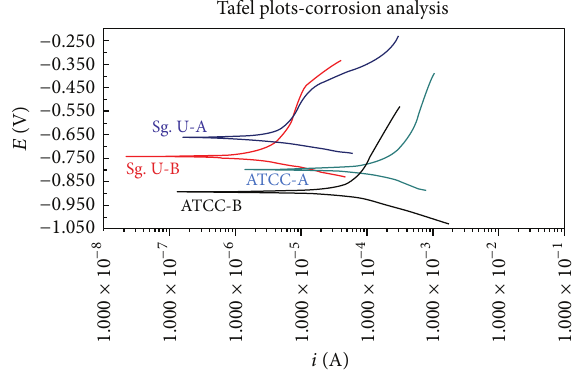
Figure 6: Tafel plot for ATCC 7757 and Sg. Ular. Sg. U-A is for Sg. Ular for a 21-day incubation period while Sg. U-B is for Sg. Ular for a 7-day incubation period. ATCC-A is ATCC 7757 SRB bacteria incubated for 21 days and ATCC-B is ATCC 7757 for 7 days.